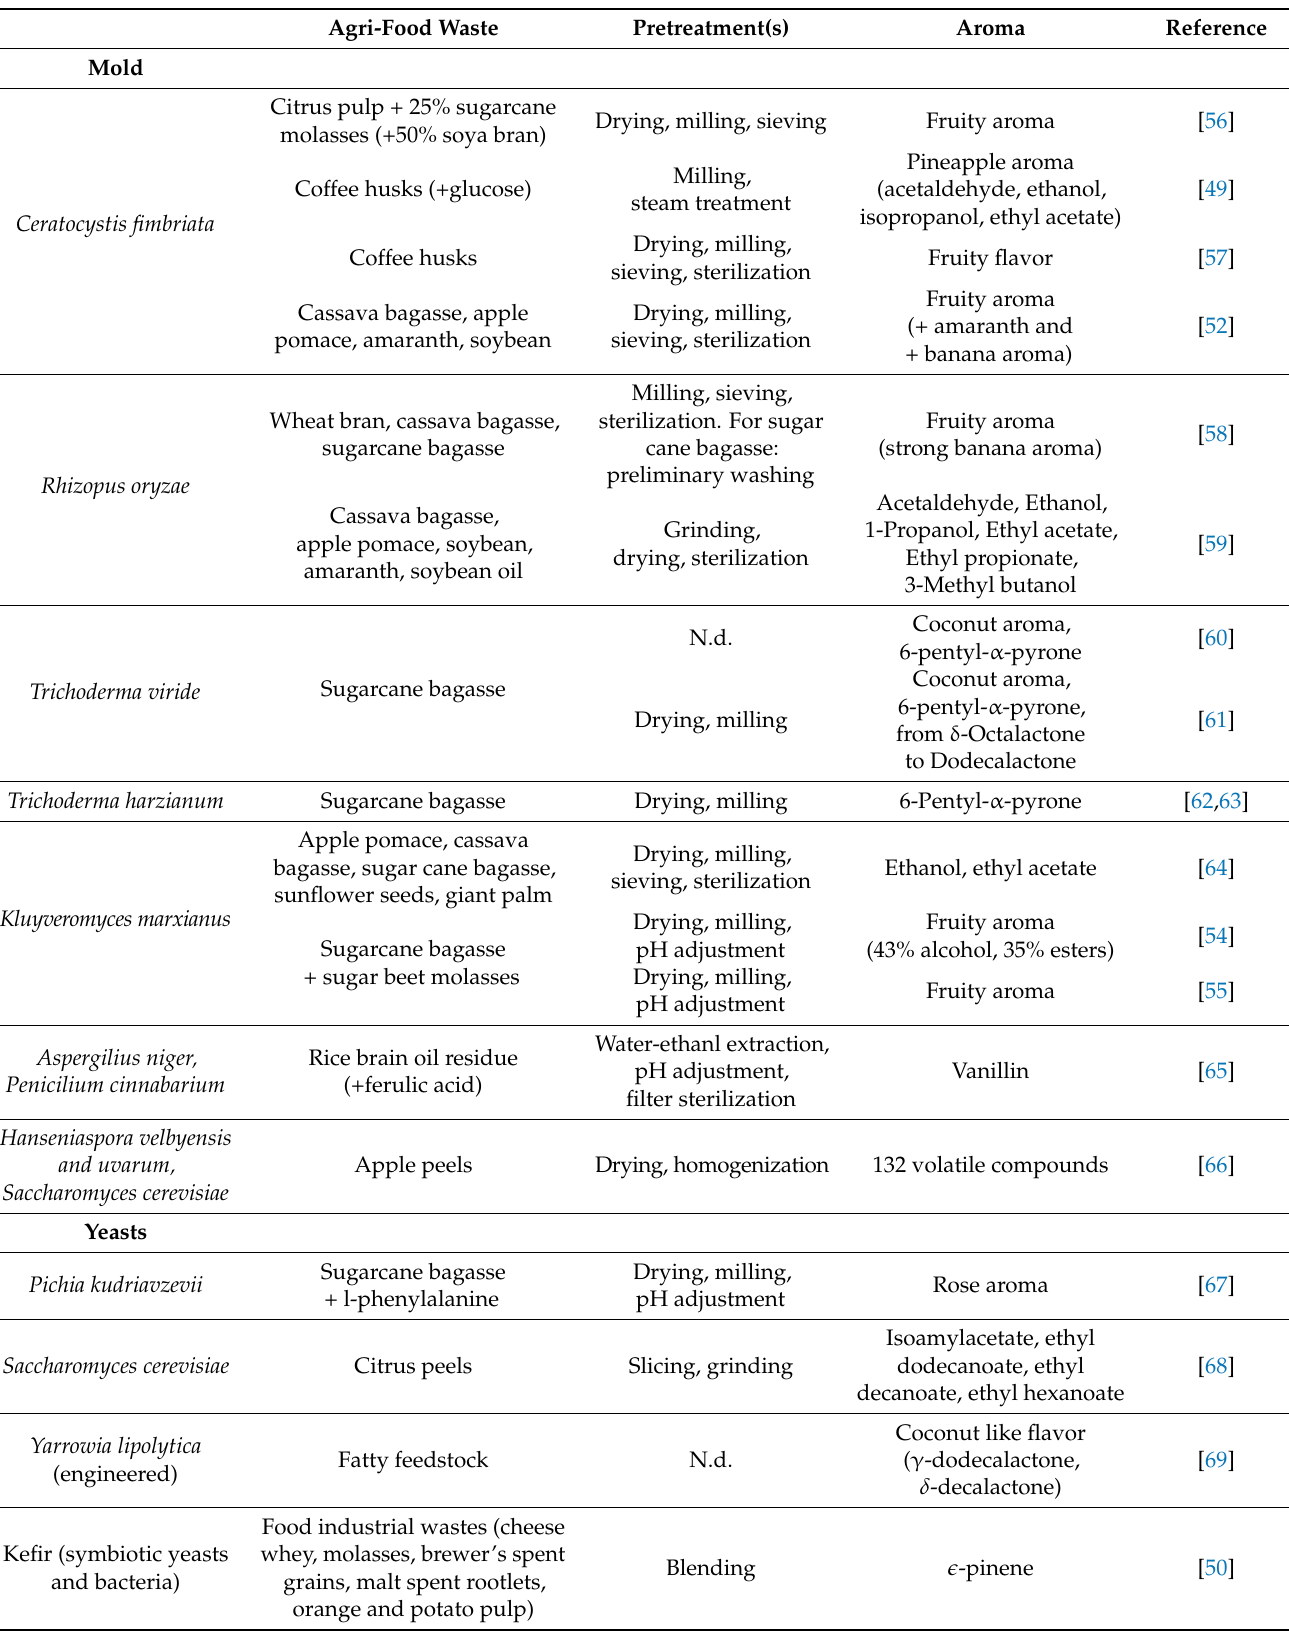
Table 1. Aroma production by SSF of agri-food wastes/byproducts, using molds and